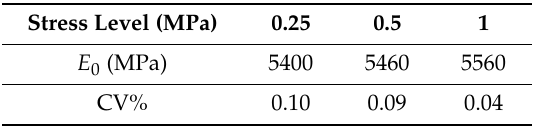
Table 7. The initial value of dynamic modulus ( E 0 ) of fatigue